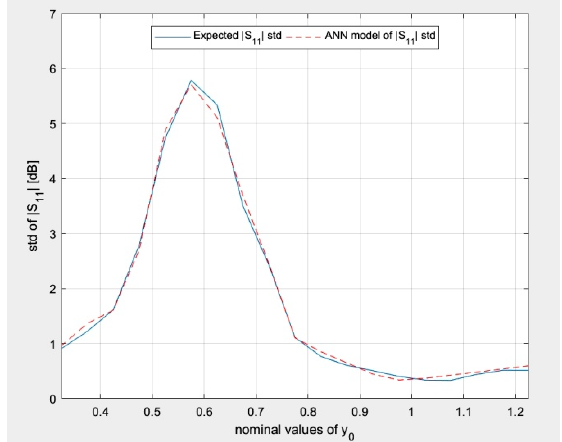
Figure 18. The expected and modeled mean of | S 11 | of an ordinary patch antenna for the range of the second set of testing data.